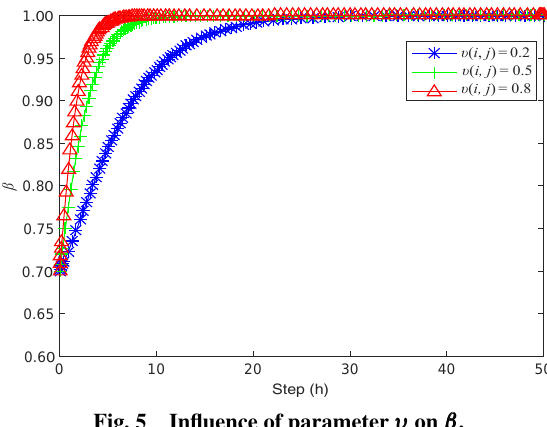
Fig. 5 Influence of parameter (cid:29)(cid:29)(cid:29) on ˇˇˇ . opinion and negatively correlated with inhibiting effect of the immune